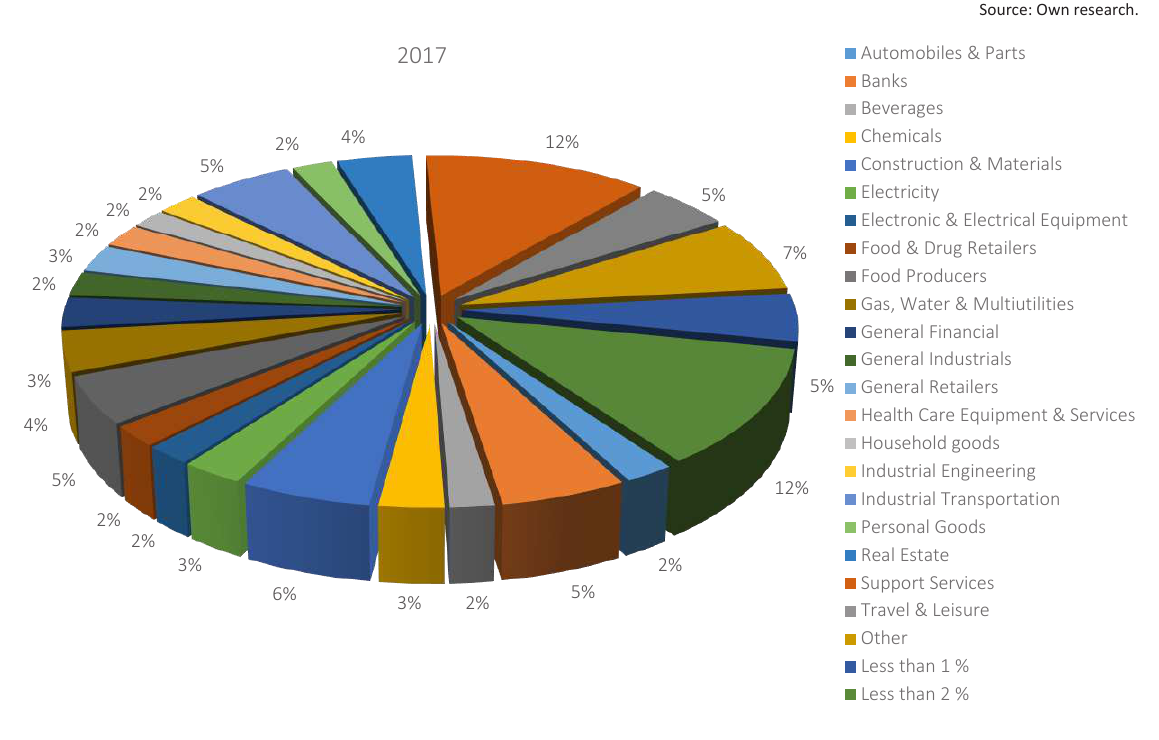
Figure 2. The percentage share of individual industries in the total number of integrated reports in the EU in 2017